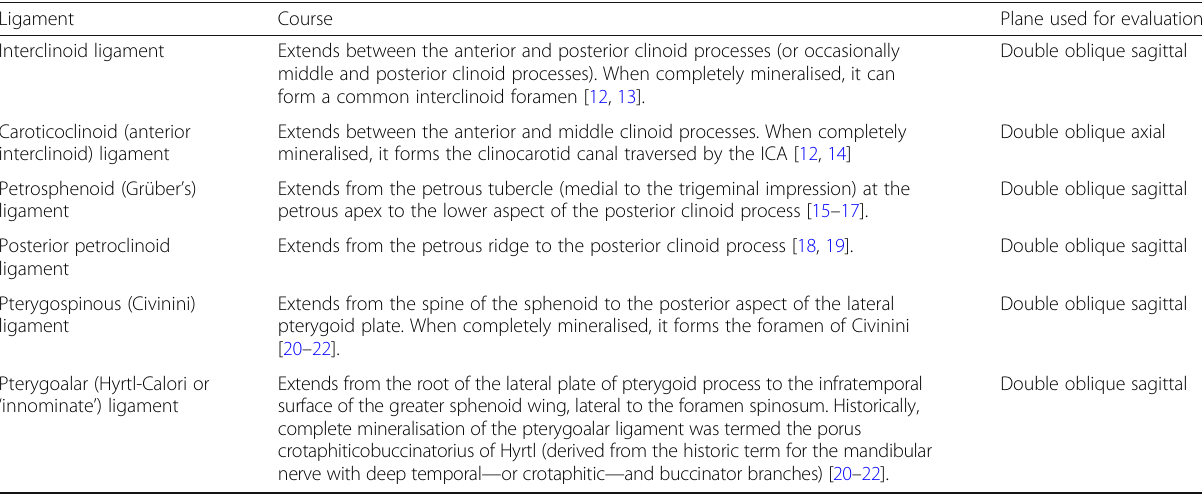
Table 1 Ligament characteristics Ligament Course Plane used for evaluation Interclinoid ligament Extends between the anterior and posterior clinoid processes (or occasionally middle and posterior clinoid processes). When completely mineralised, it can form a common interclinoid foramen [12, 13]. Caroticoclinoid (anterior interclinoid) ligament Petrosphenoid (Grüber ’ s) ligament Posterior petroclinoid ligament Pterygospinous (Civinini)